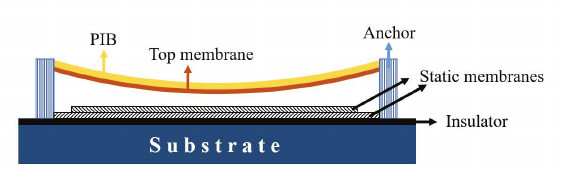
Figure 10. Schematic view of a CMUT sensor where the top flexible membrane is coated with a thin layer of